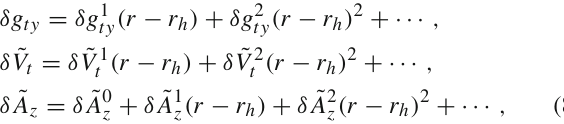
(left) and the transport coefficient ξ (right) as a function of B / T 2 when α = λ = 0 h